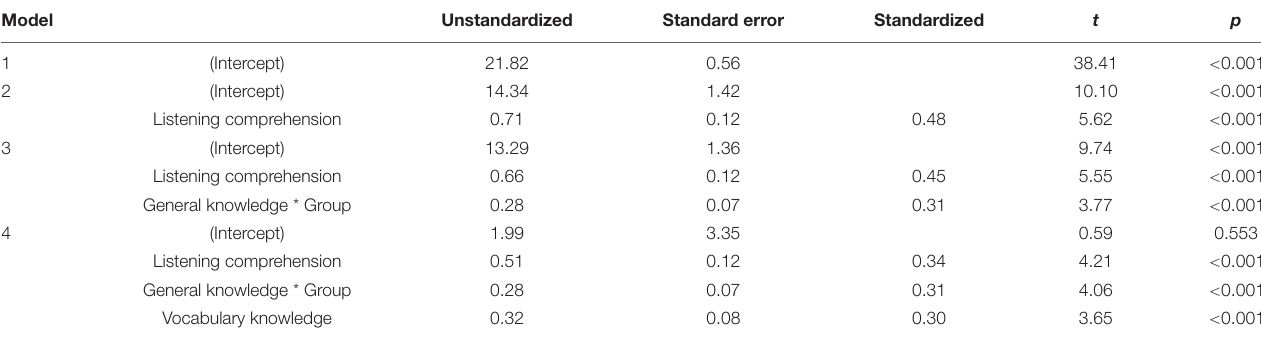
TABLE 5 | Regression coefficients of the